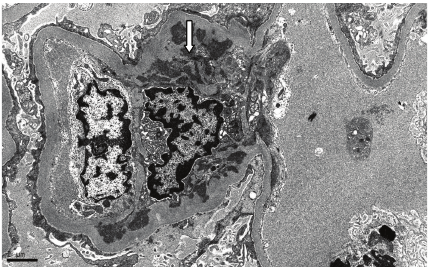
Figure 5: Collapsing lesion of focal segmental glomerulosclerosis with GBM wrinkling and mesangial deposits